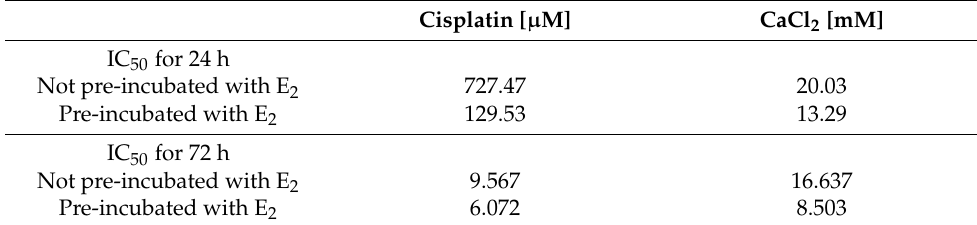
Table 1. IC 50 values for cisplatin and calcium chloride (CaCl 2